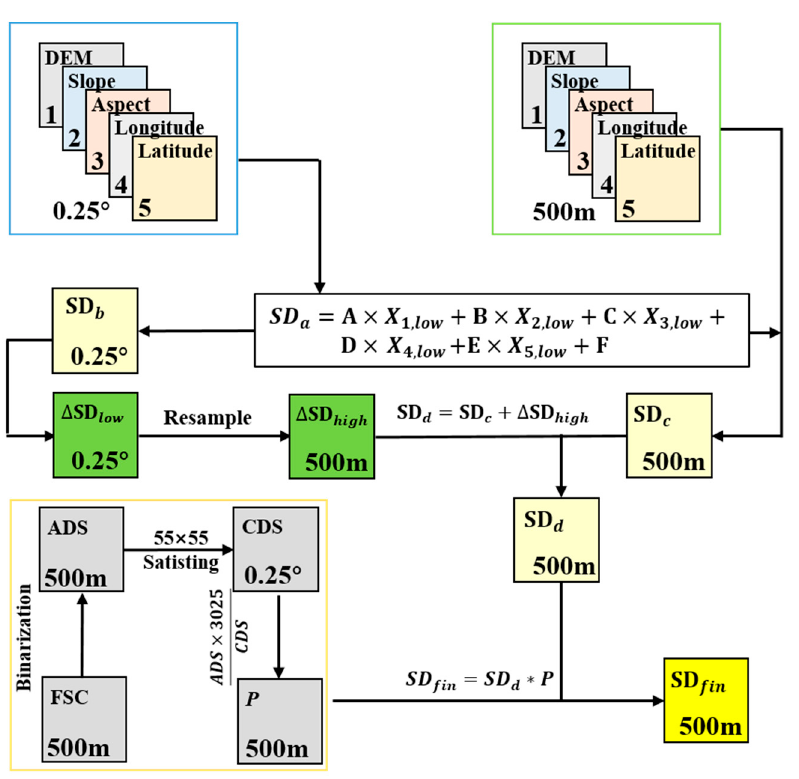
Figure 2. Schematic diagram of the statistical-based method and the improvement from introducing snow distribution probability for downscaling SD data.